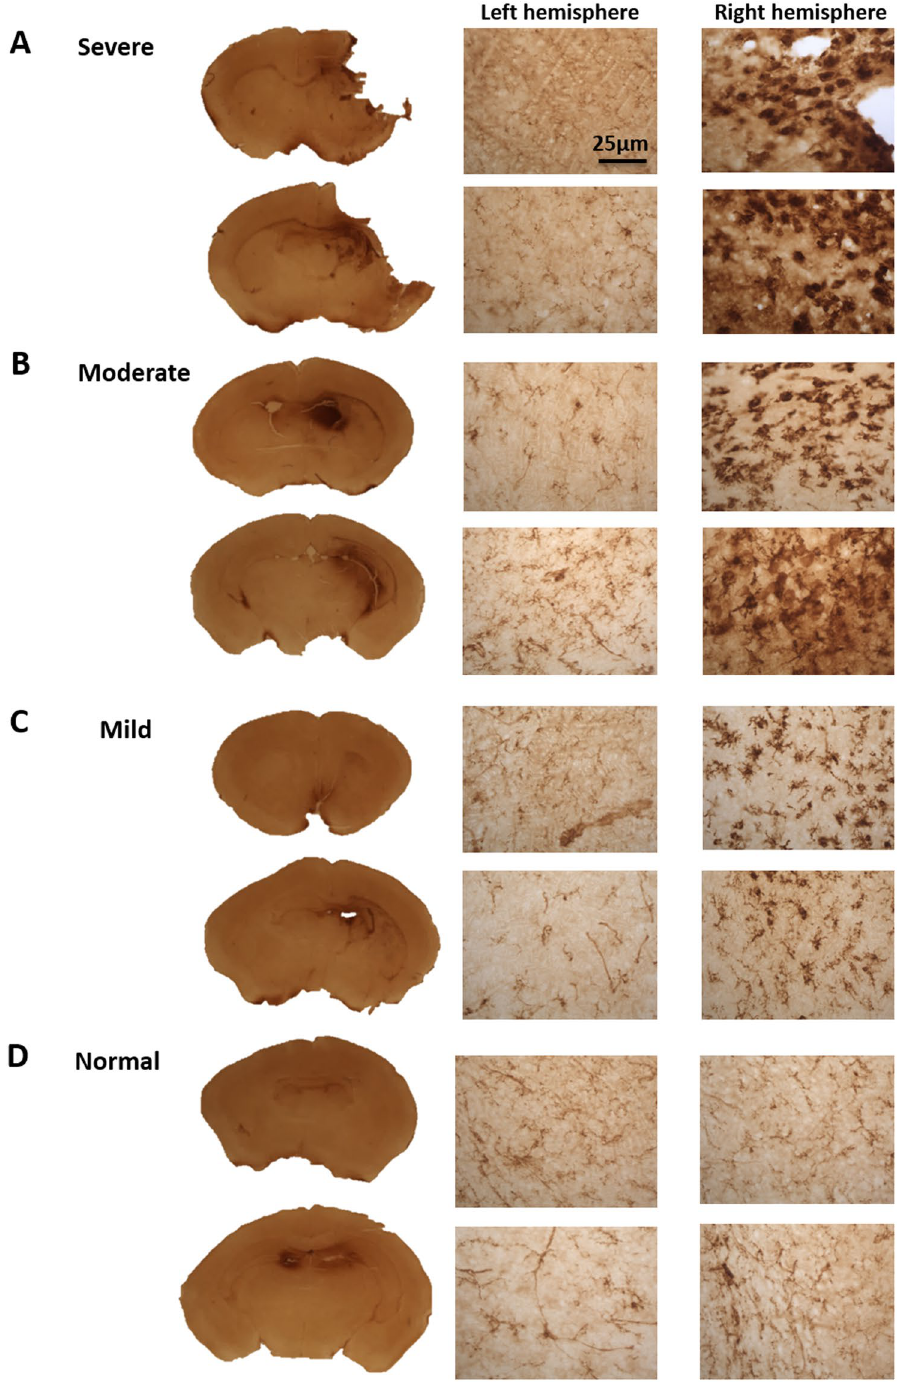
Figure 5. Reactive microglia immunohistochemistry on HIE brains harvested 48 hours after surgery. Reactive microglia was detected by conducting a CD68 immunohistochemistry on the variable HIE brains. ( A ) Severe brains showed reactive microglia within the cortex and the hippocampus of the right lesioned hemisphere. CD68 positive cells were also found within the ( B ) moderate and ( C ) mild right hemisphere. Whereas CD68 expression was, absent from the ( D ) normal brain. The brain section images were taken at × 5 magnification and the left and right hemisphere images were taken at × 40